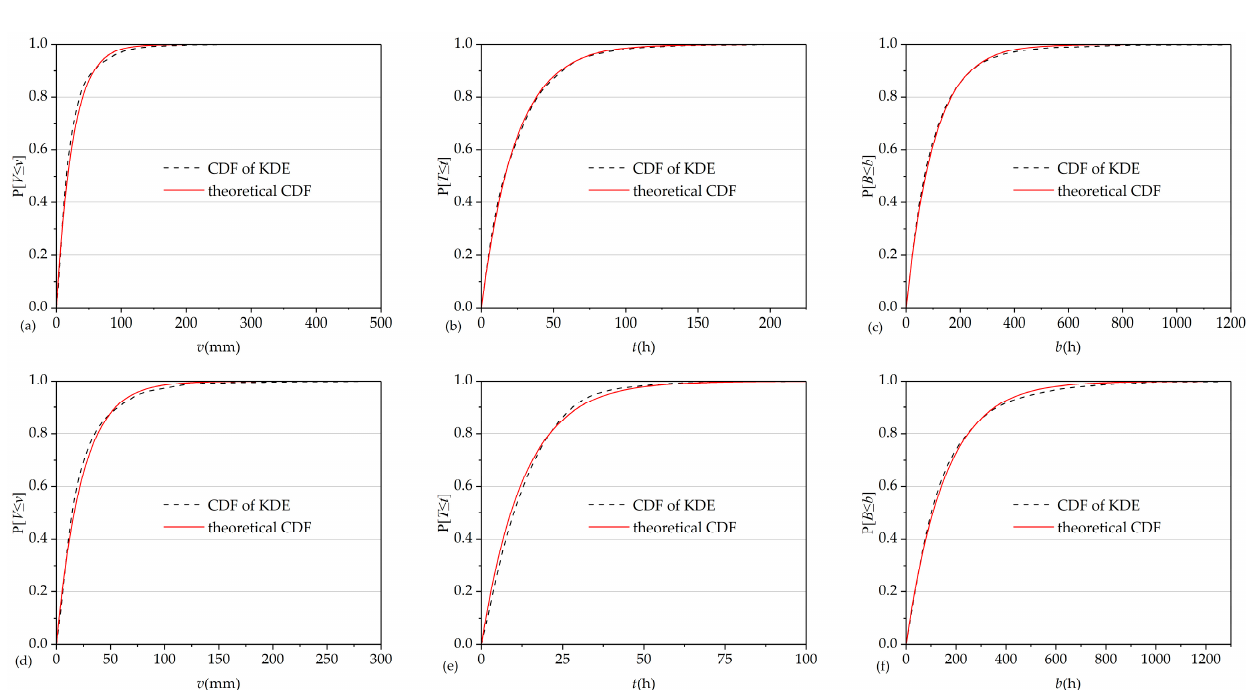
Figure 5. Comparison of CDF of KDE and theoretical exponential CDF of rainfall event volume v , rainfall event duration t , rainfall inter-event time b for the optimal MIET and rainfall event volume threshold: ( a – c ) Hangzhou (MIET = 12 h, v t = 3 mm); ( d – f ) Jinan (MIET = 10 h, v t = 3 mm).